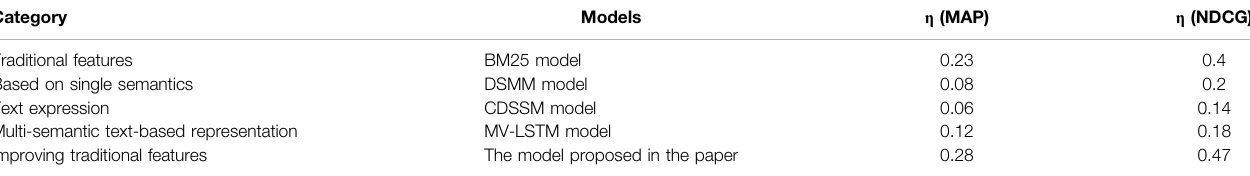
TABLE 3 | Results of the model in the matching of similar and correlated work